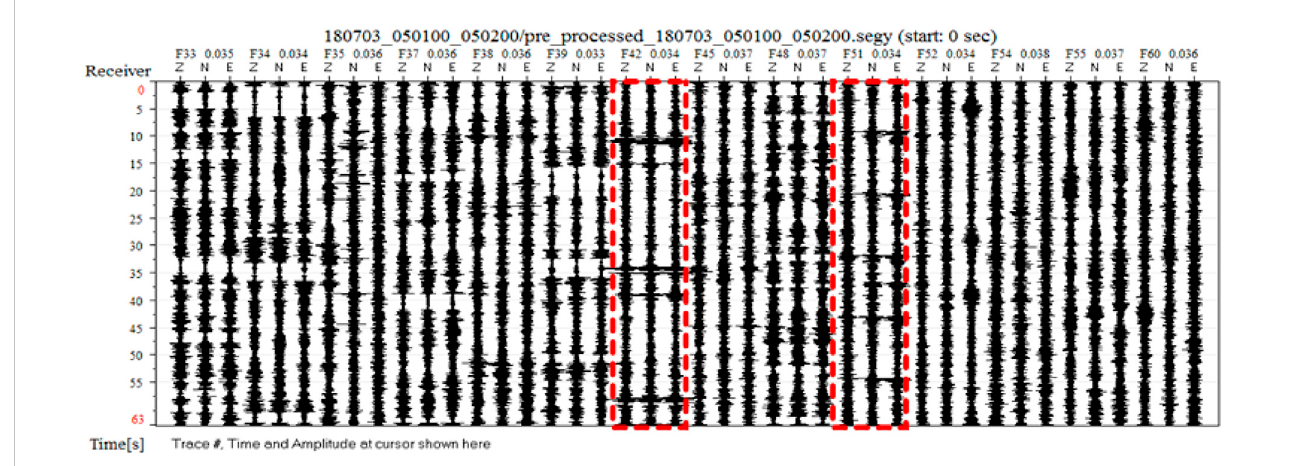
FIGURE 5 Typical data of fracturing monitoring before noise removal of Well